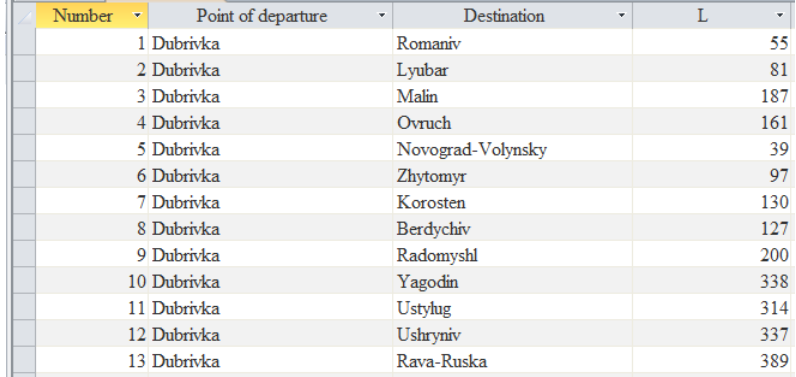
Figure 2: Database of distances between CPs, points of departure and destination